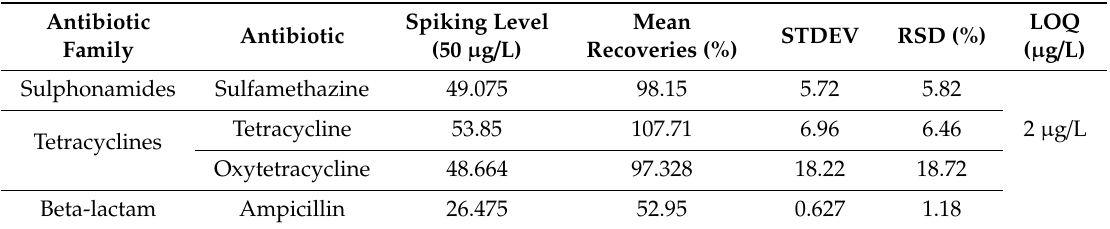
Table 4. Results of in-house verification of the LC-MS / MS method for the antibiotics considered in this study, with the standard deviation (STDEV), relative standard deviation of repeatability (RSD) and limits of quantification (LOQ).